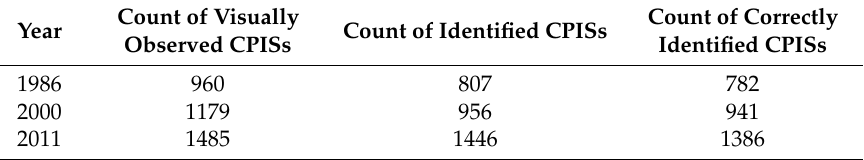
Table 2. Quantity analysis results in three different